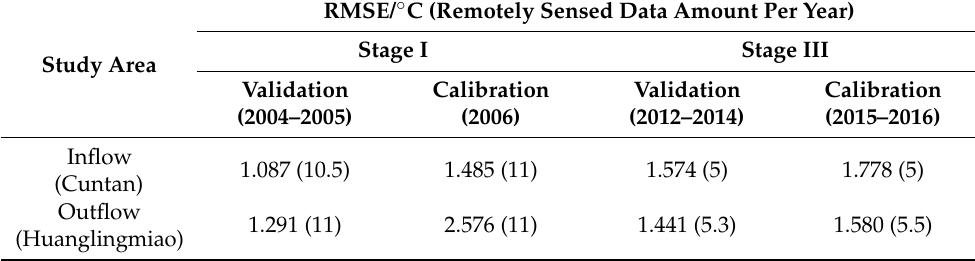
Table 2. The RMSE of air2stream simulated daily RWT and the available quantity of remotely sensed data per year in the calibration and validation periods during Stage I and